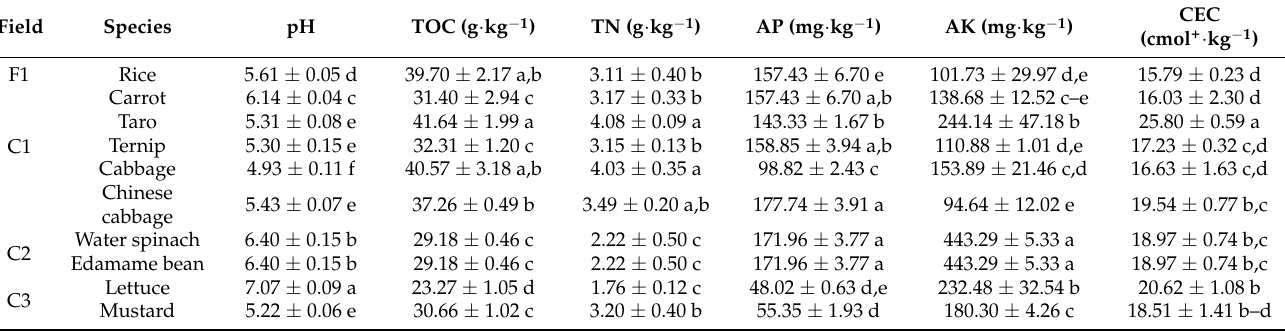
Table 2. Physiochemical properties of rhizosphere soils.